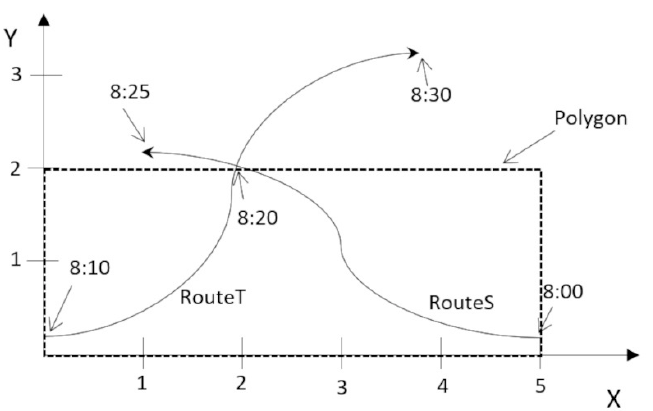
Figure 2. Examples of temporal-spatial types: delivery Path of trucks.